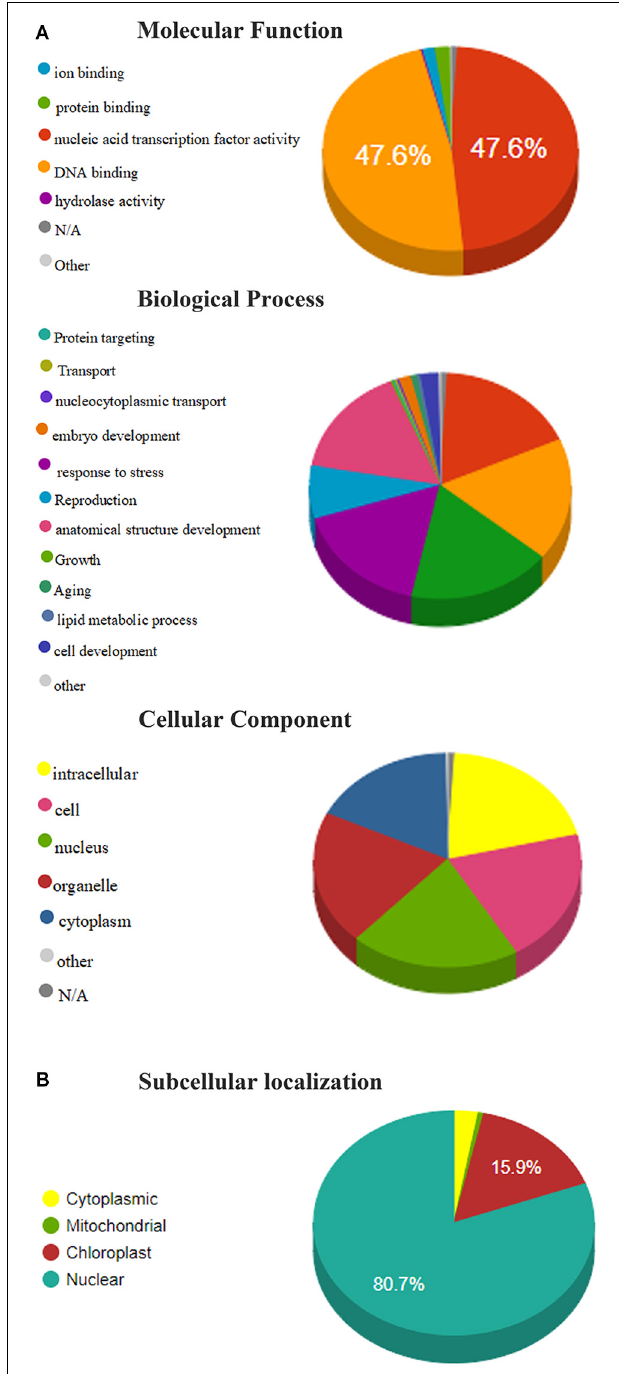
FIGURE 5 | (A) Molecular functions, biological processes, and cellular component of members of the TaAP2/ERF family based on gene ontology (GO) analysis. (B) Subcellular localization of TaAP2/ERF protein in Wheat.